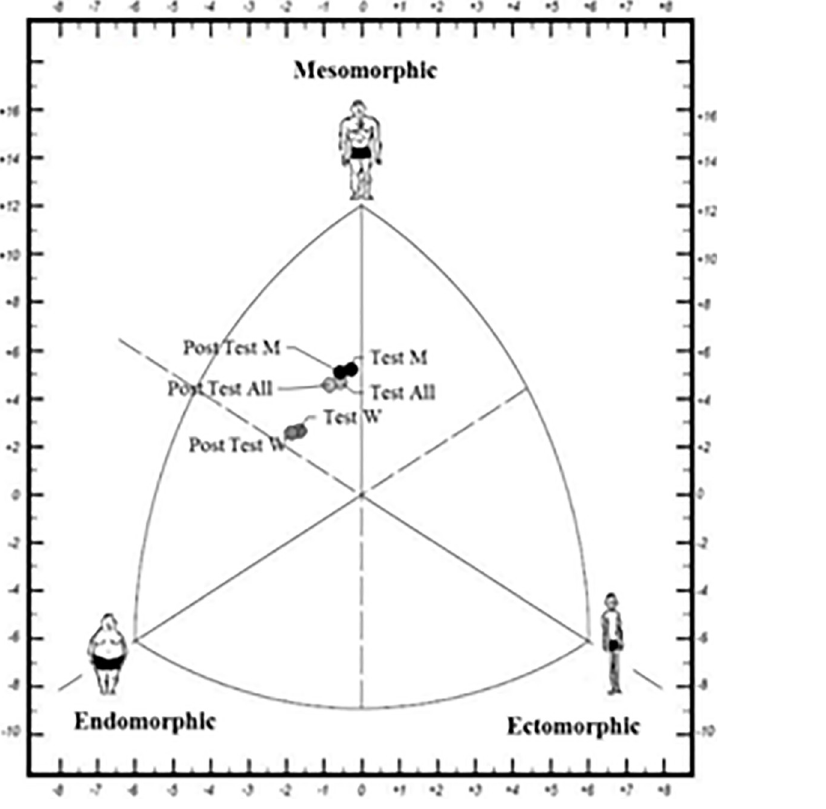
Fig 3. Somatotype before and after 12 weeks without mandatory physical